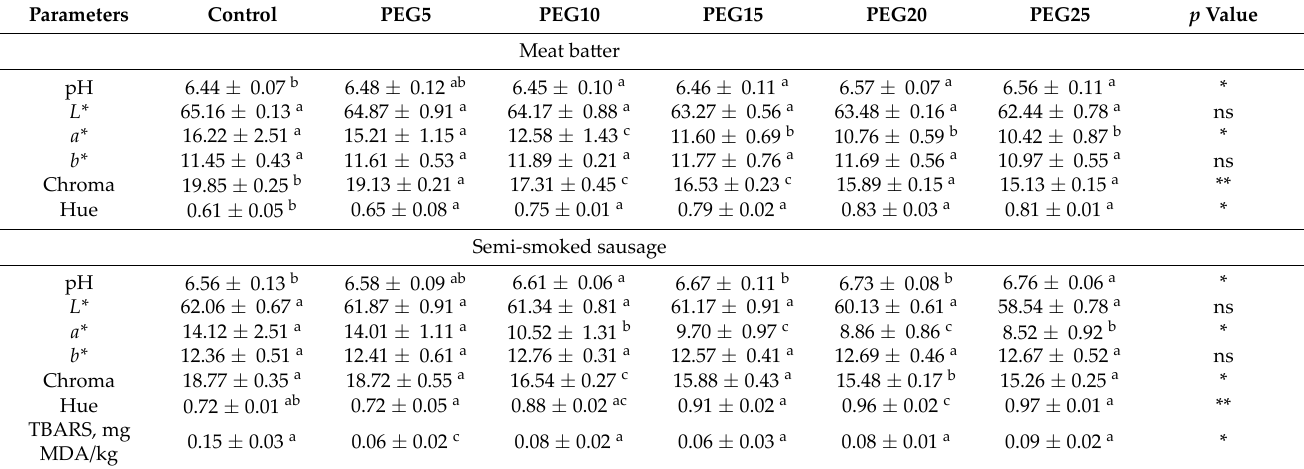
Table 4. The color, pH, and TBARS parameters of mixed horsemeat emulsions and